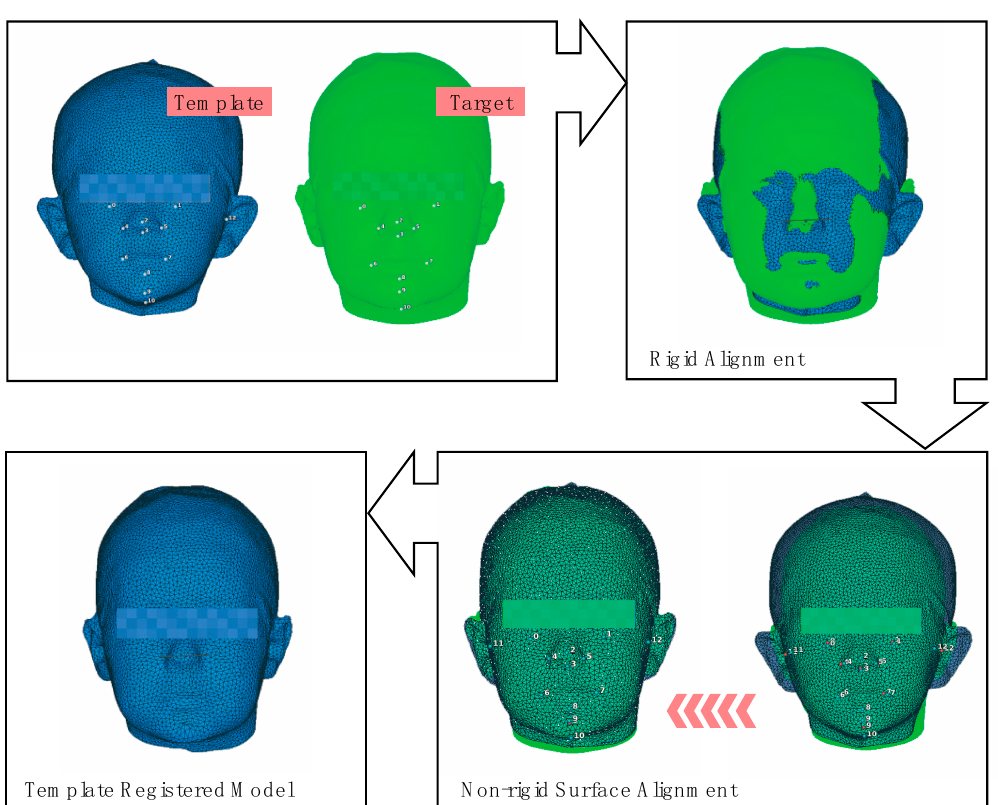
Figure 3. The template registration process.